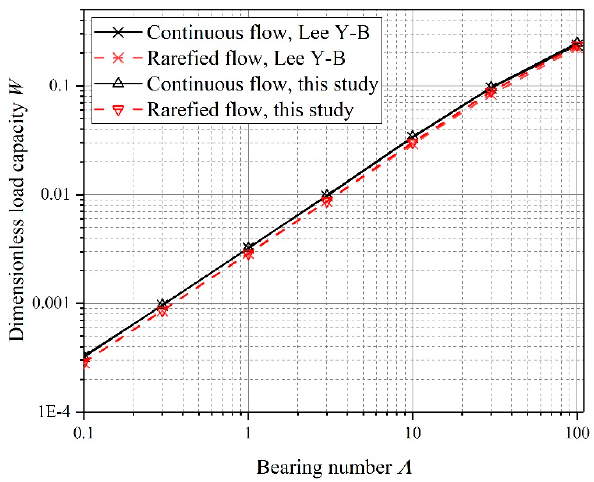
Figure 6. Comparison between the results of this paper and Lee Y-B.